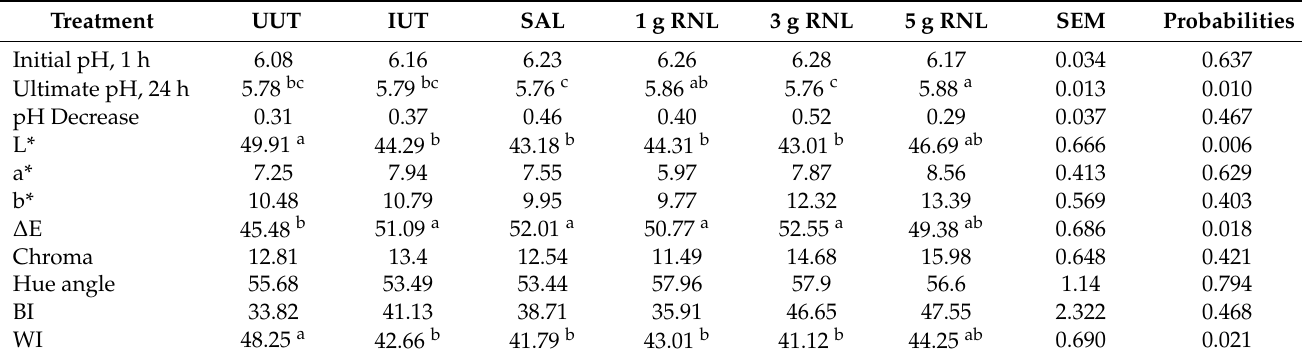
index (WI2) of breast meat were significantly different between experimental groups and the controls ( p < 0.05). On the other hand, initial pH, initial lightness, initial total color change ( ∆ E), and final yellowness did not differ between experimental treatments ( p > 0.05). In addition, the initial and final redness, hue angle, browning index (BI), and saturation index (Chroma) did not differ between experimental treatments ( p > 0.05). Table 4. The pH and color of breast meat (pectoralis major) were measured at 34 days of age in broiler chickens fed diets containing different levels of Rumex nervosus leaves (RNL), 24 hours (h)